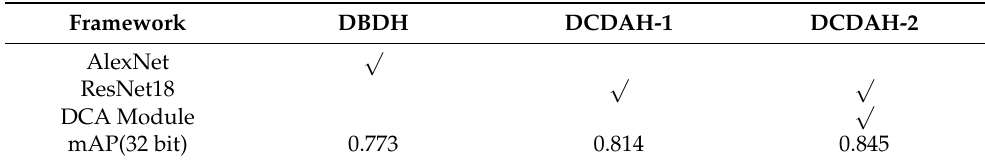
Table 5. Comparative